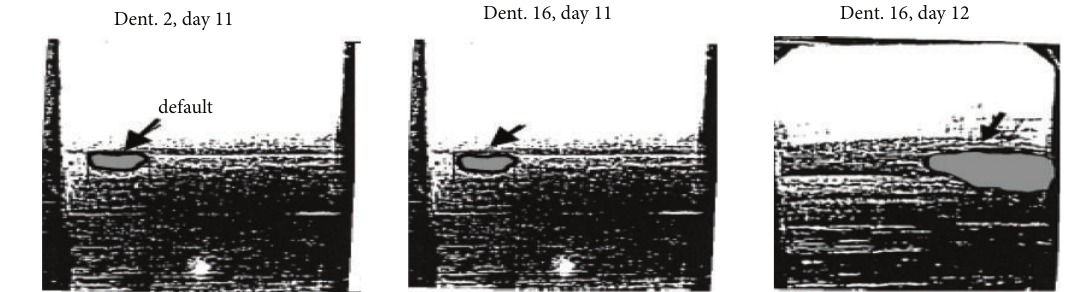
Figure 10: Evolution of the chipping.